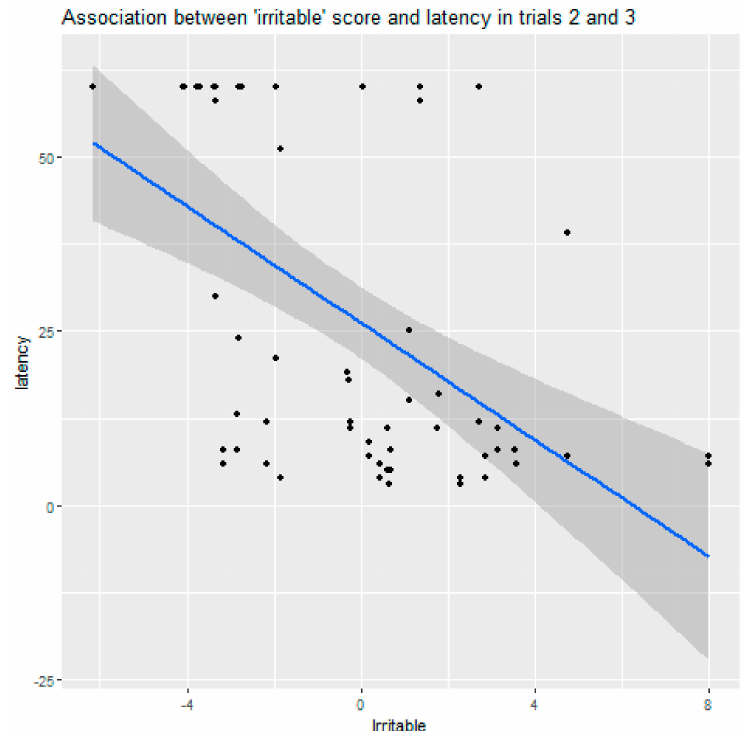
Figure 3. More “irritable” dogs solved the detour faster after the experimenter demonstrated the